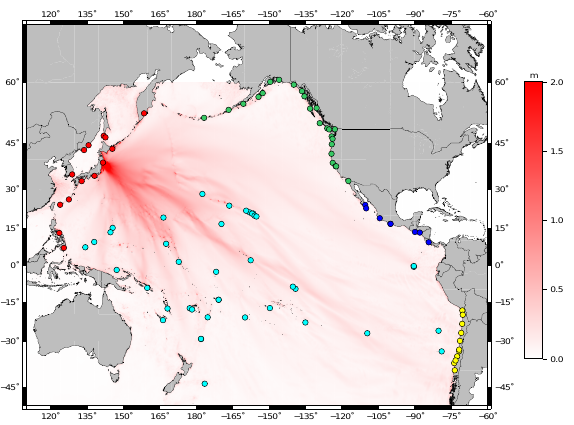
Fig. 1a. Map of the Pacific Ocean with the simulated field of the maximum sea surface elevation for the 11 March 2011 Tohoku tsunami with the tide-gauge stations considered in the analysis, from all Pacific coasts: Asia (red), North America (green), Central America (blue), South America (yellow) and Pacific Islands (light blue). The simulation (Tinti et al., 2011) is based on the initial con- dition by H¨ochner et al. (2011).